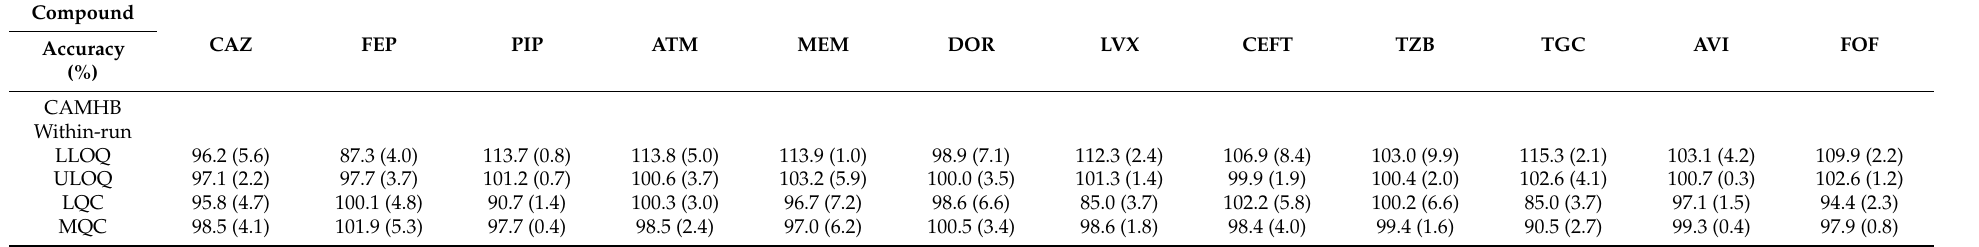
Table 3. Within- and between-run accuracies of 12 compounds in CAMHB for LLOQ, ULOQ, LQC, MQC and